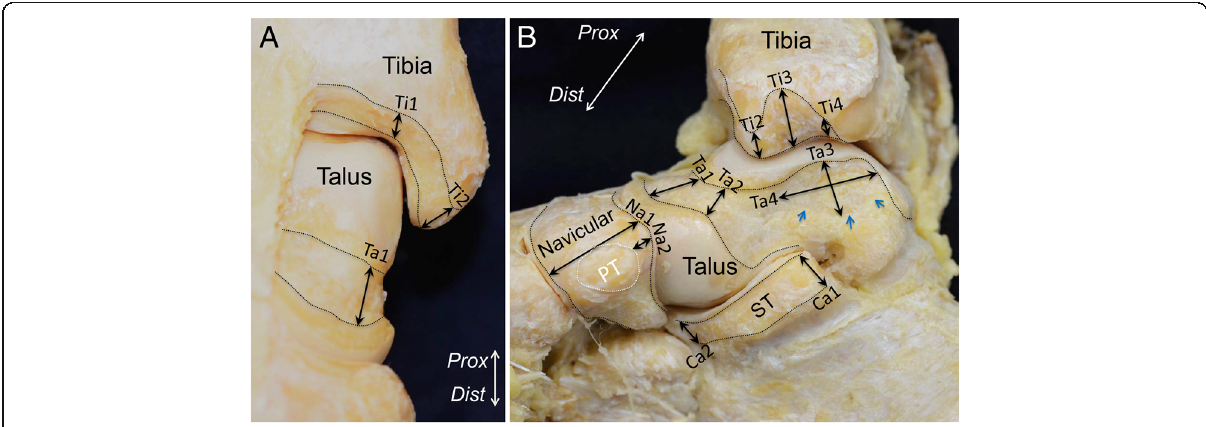
Fig. 5 Measurements of the width of the capsule attachment. Detailed data are shown in Table 1. a Attachment of the anterior part of the continuous capsule. b Attachment of the medial part of the continuous capsule. The black dotted line indicates the attachment of the joint capsule. The white dotted line indicates insertion of the posterior tibialis tendon. Prox, proximal; Dist, distal; PT , insertion of the posterior tibialis tendon; ST , sustentaculum